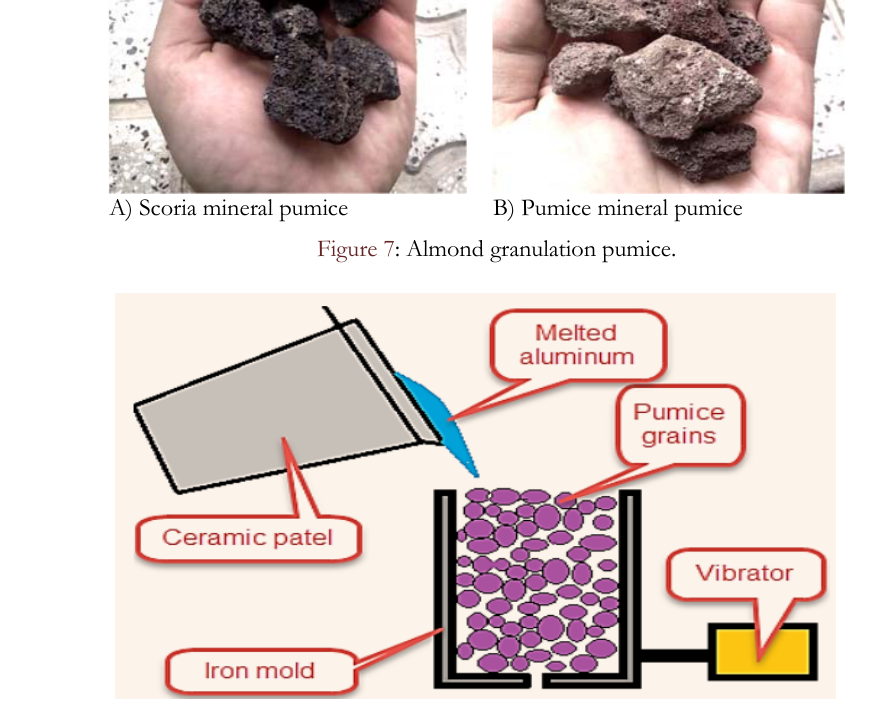
Figure 8 : Made test